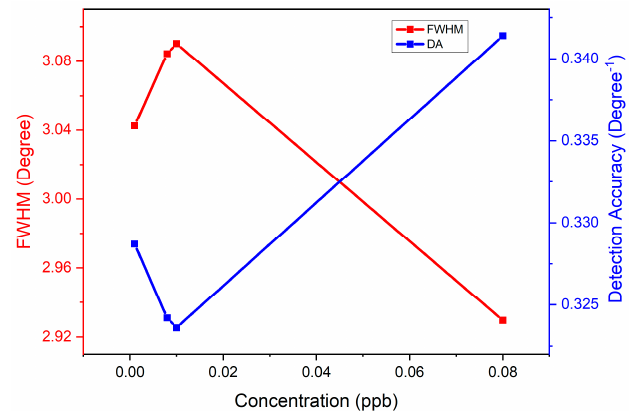
Nanomaterials 2022 , 12 , x FOR PEER REVIEW Figure 16. Graph of FWHM and DA versus concentration of carbaryl. Figure 16. Graph of FWHM and DA versus concentration of carbaryl.